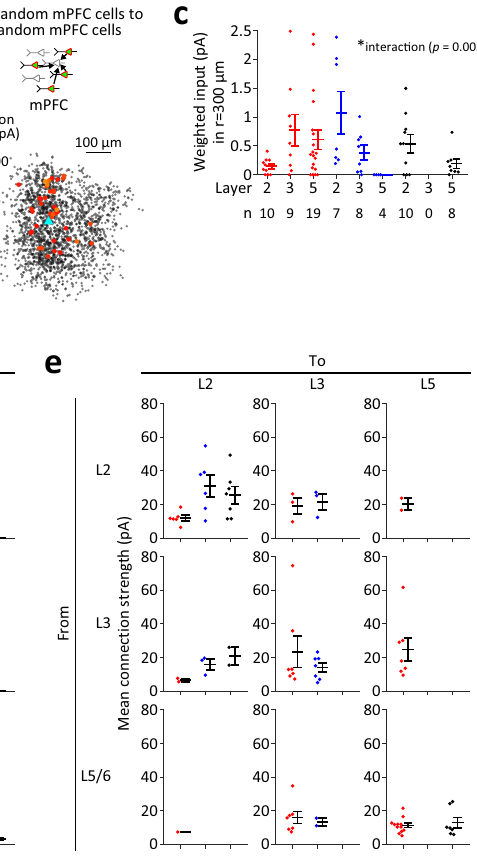
Fig. 3 | Functional synaptic connectivity in cell populations of the ventral mPFC. a Description of the three types of synaptic connections measured. b Overlay of all connectivity maps obtained for each connection type in a . Stimu- lated cells are in shaded black, and connected (presynaptic) cells are color coded for connection strength. All cell locations are relative to their corresponding recorded (postsynaptic) cell position (withinthe same map), which ispresented as a cyan triangle at the center of the overlaid maps. Positions along the depth of the slice (anteroposterior axis) are collapsed. c Weighted synaptic input according to the layer of the postsynaptic cell, for each connection type. Zero weighted input indicates that none of the stimulated cells were connected to the recorded cell. * Two-wayANOVA interaction effectbetween layer and connectiontype, F (4) = 5.2, p